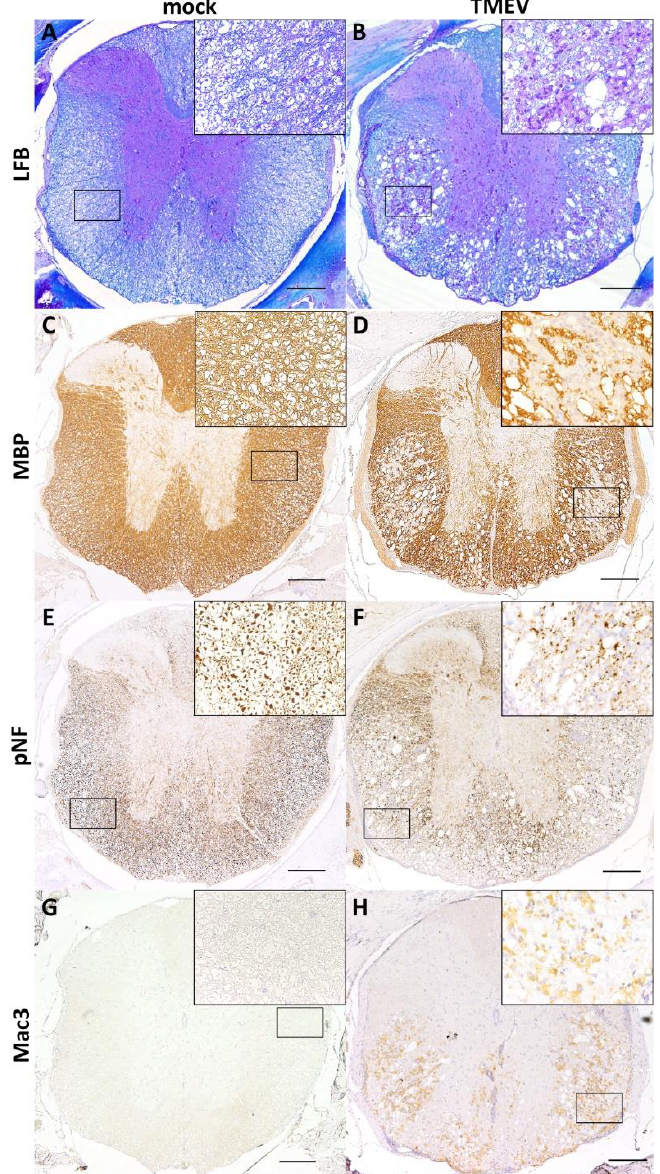
Figure 6. Histochemical and immunohistochemical evaluation of SC segments using Luxol fast blue (LFB) staining ( A : mock infected animal showing regularly myelinated white matter; B : TMEV infected animal with multifocal areas of demyelination). Immunohistochemistry targeting myelin basic protein (MBP; C : mock infected animal showing regularly myelinated white matter; D : TMEV infected animal with multifocal demyelination), phosphorylated neurofilaments (pNF; E : mock infected animal showing regularly distributed pNF labeled axons; F : TMEV infected animal with multifocal loss of pNF labeled axons) and microglia/ macrophages (Mac3; G : mock infected animal showing no immunolabeled cells; H : TMEV infected animal revealing multifocal immunolabeled cells within the white matter). Pictures show the thoracic segment of a mock (clinical score: 0, rotarod: 27.8 rpm) and a TMEV-infected animal (clinical score: 4; rotarod: 14.5 rpm) at 98 dpi. Scale bars = 200 μm. Inserts in 400× magnification.